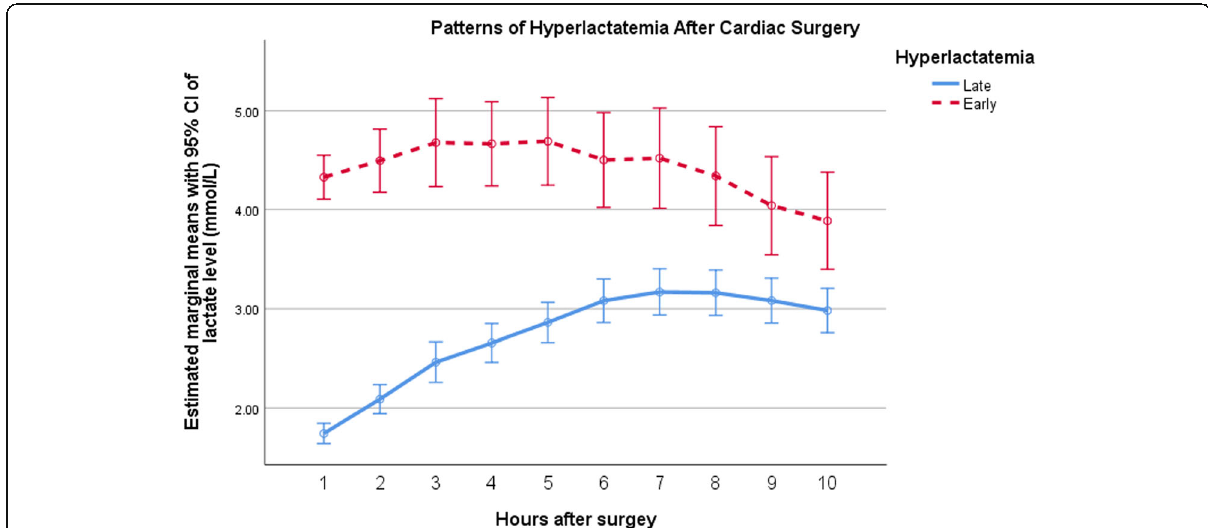
Fig. 1 Patterns of hyperlactatemia after cardiac surgery. Bars represent the 95% confidence intervals. The lactate levels change over time and it is significantly different in both groups (within-subjects P value < 0.001). Similarly, lactate levels are significantly different between the two groups at all time points (between-subjects P value < 0.001). Estimated marginal means for lactate levels with the 95% CI for each time point in both groups are detailed in the Supplement (Table